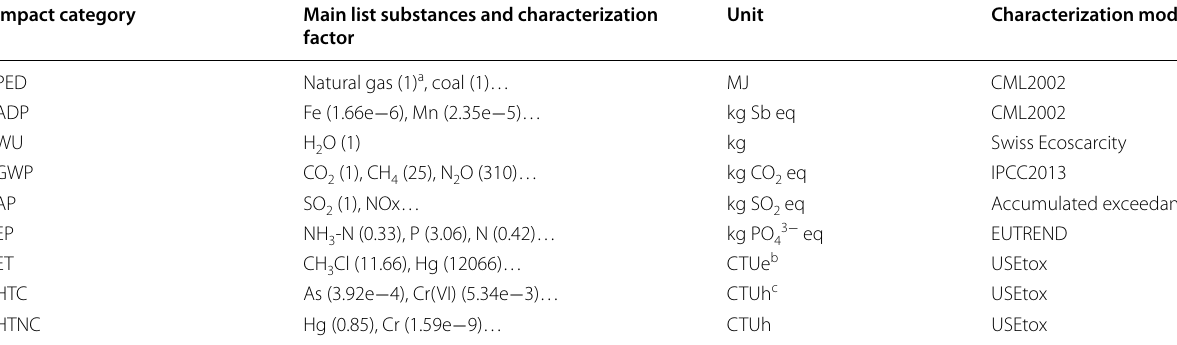
a Natural gas (1) represents that the characterization factor of natural gas in PED is 1; b CTUe represents Comparative Toxic Unit for ecosystems; c CTUh represents Comparative Toxic Unit for humans